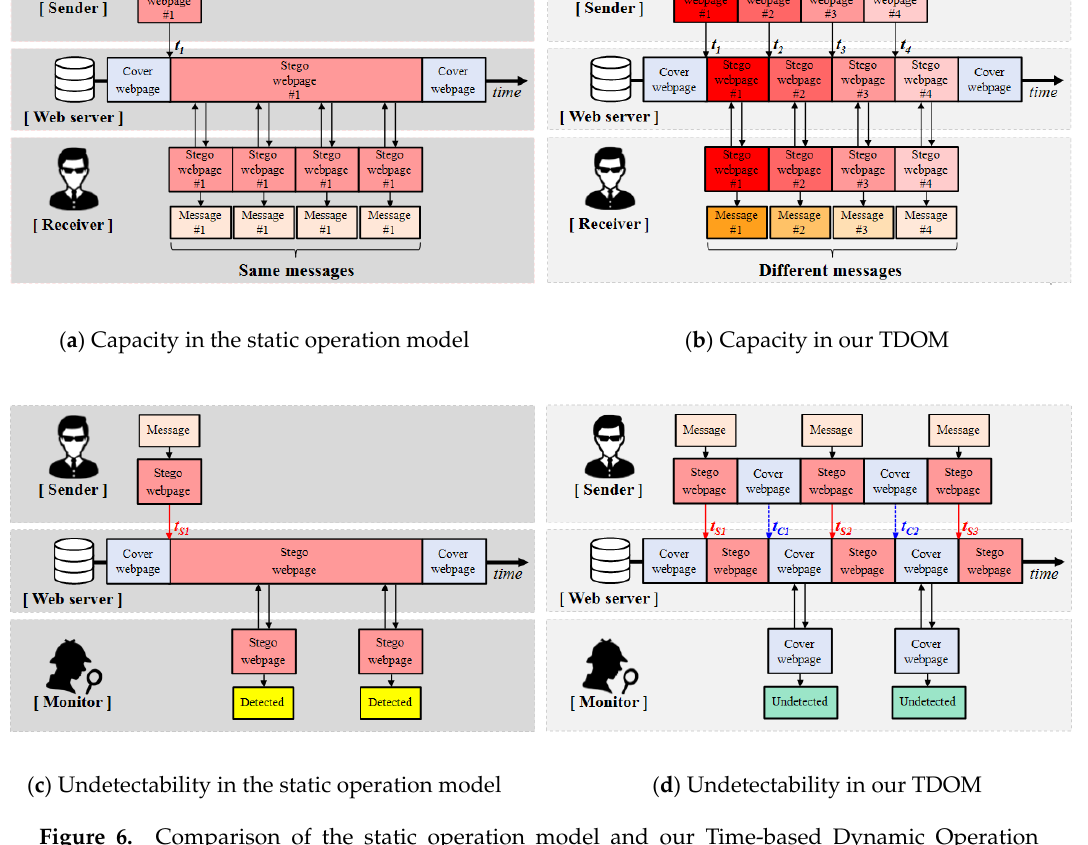
Figure 6. Comparison of the static operation model and our Time-based Dynamic Operation Model (TDOM).